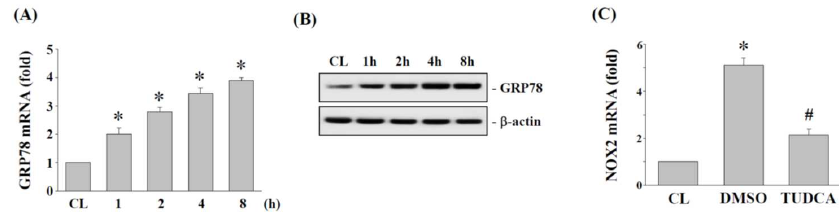
Figure 4. HCS-induced NOX2 is mediated by ER stress. ( A , B ) HAFCs were exposed to 15% HCS for the indicated times, and the expression level of GRP78 mRNA (A) were determined by real-time PCR analysis. The results are mean ± standard error of the mean (SEM). The protein expressions of GRP78 were determined by Western blot analysis ( B ). Bars in ( B ) are the mean and SEM fold change in band density relative to control, normalized to total protein levels from three independent experiments. * p < 0.05 versus CL. ( C ) HAFCs were kept as CL or exposed to 15% HCS. Before being kept as CL or exposed to stretch, HAFCs were pretreated with TUDCA (ER stress inhibitor) for 1 h and then exposed to 15% HCS for 4h, and the expression levels of NOX2 mRNA were determined by real-time PCR analysis. The results are shown as mean ± SEM. * p < 0.05 vs. CL. # p < 0.05 versus si-CL with 15% stretch stimulation.